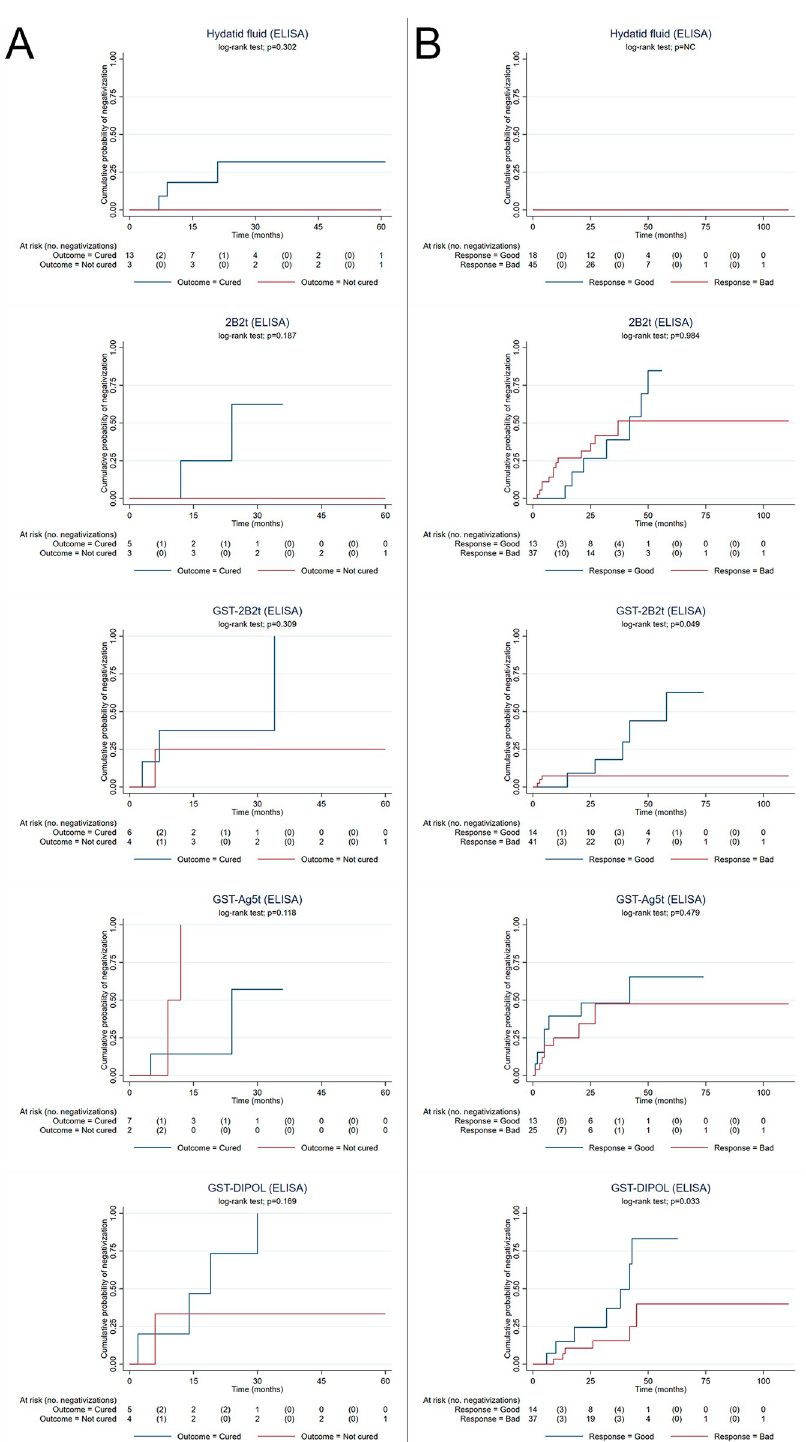
Fig 4. Kaplan-Meier estimates of the cumulative probability of negativization against the different tests over time in: (A) cured (blue line) and not cured (red line) patients who underwent surgical or percutaneous treatment; (B) patients with good (blue line) and bad response (red line) to albendazole treatment. Censored patients/samples, these can be derived by difference, and were due to missing attendance to the follow-up visit or no availability of serum leftover from routine serology to be stored for